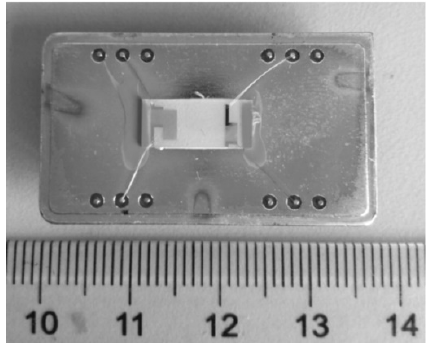
Figure 2. Love wave device with ZnO waveguide layer fabricated at 150 °C.